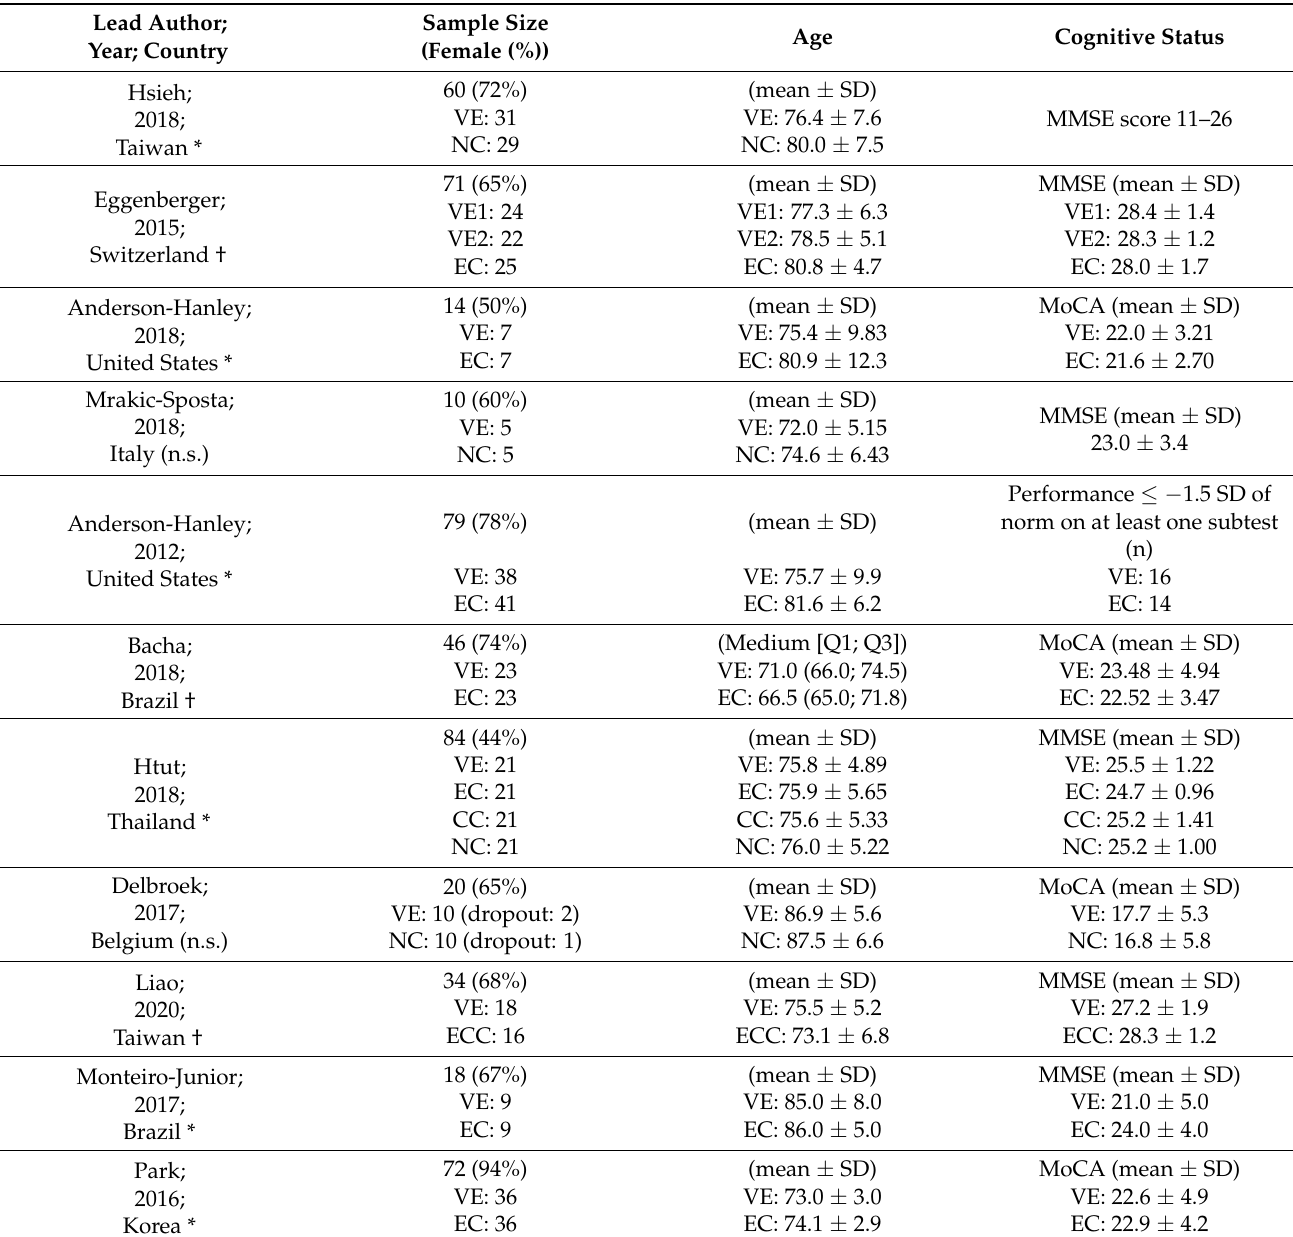
Table 1. Characteristics of participants in the included